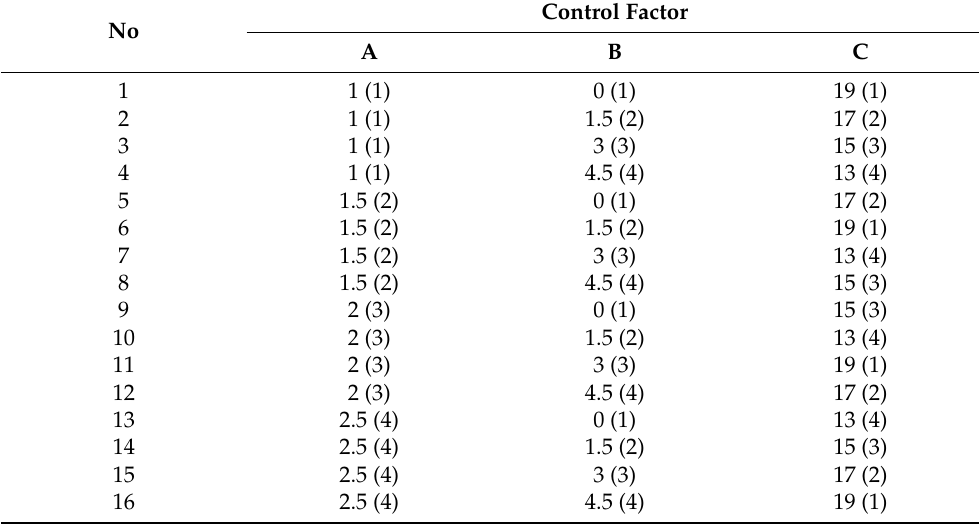
Table 3. Control factors and levels of FP-AFPMG.